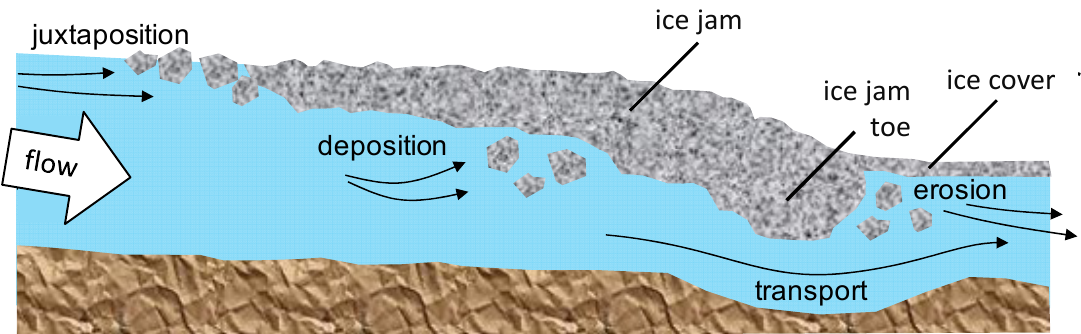
Figure 6. Illustration scheme of established ice jam with ice erosion from the ice jam toe and scour of the river bed below the ice